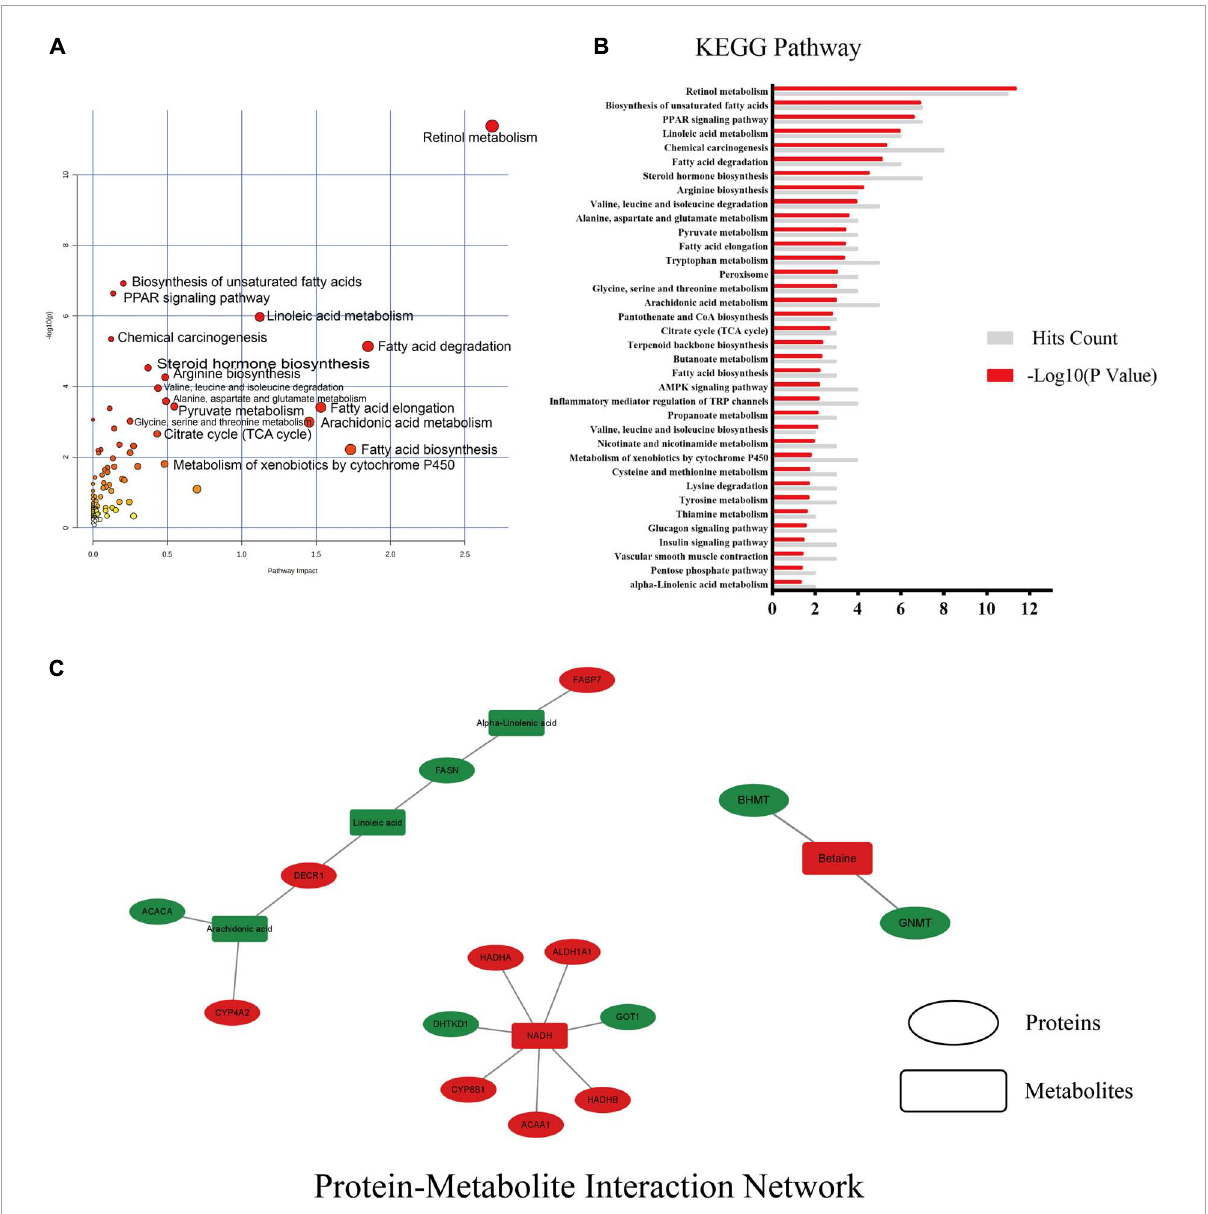
FIGURE5 Results of combined multi-omics analysis. (A) KEGG pathway with pathway impact and significance. Pathway impact is a combination of the centrality and pathway enrichment results, it is a tool to measure centrality or “hubness” in an objective manner. (B) KEGG enrichment pathway with significant differences and the number of hits on that pathway. (C) protein-metabolite interaction network of differential proteins and differential metabolites. Ellipses indicate proteins and rectangles indicate metabolites, red indicates up-regulation after MSS intervention, green indicates down-regulation after MSS